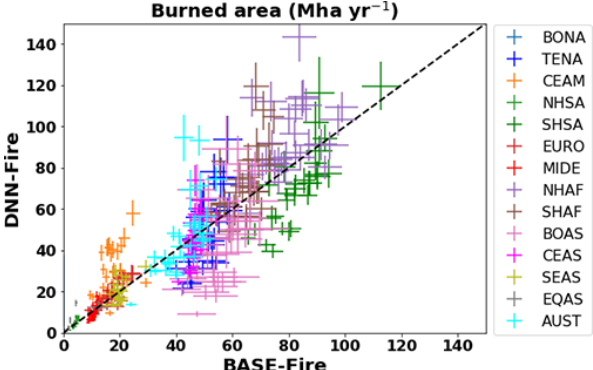
Figure 4. The performance of the deep neural network wildfire model (DNN-Fire), compared with the original ELMv1 process- based wildfire model (BASE-Fire) over 14 GFED regions between years 2001 and